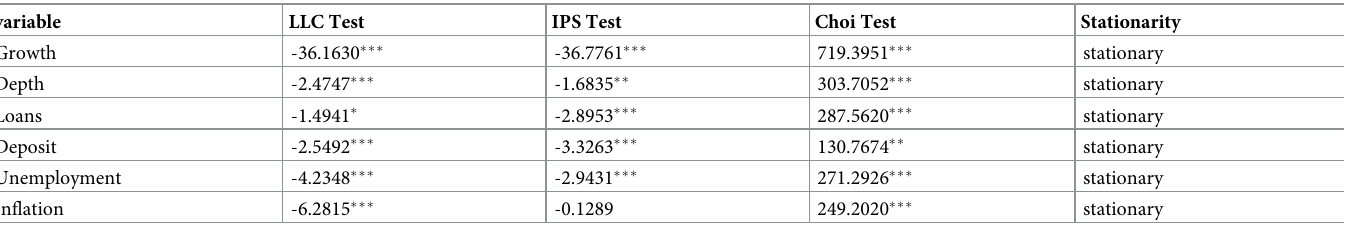
Table 2. Results of panel unit root